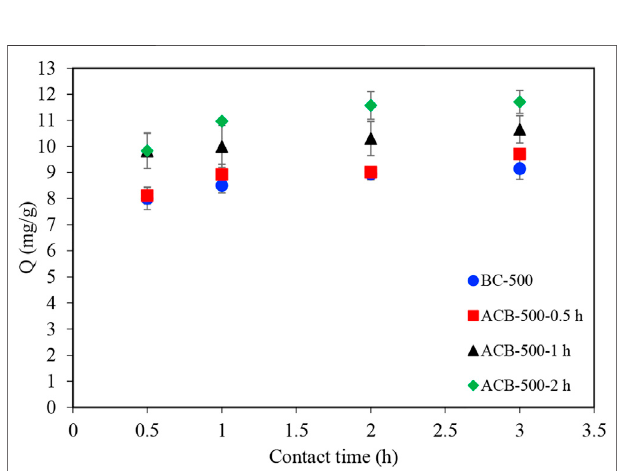
FIGURE 6 | XRD patterns of two samples of bio-char produced at 600 and 650 ° C, and four samples of activated bio-char with activation time changes from 0.5 to 3 h.